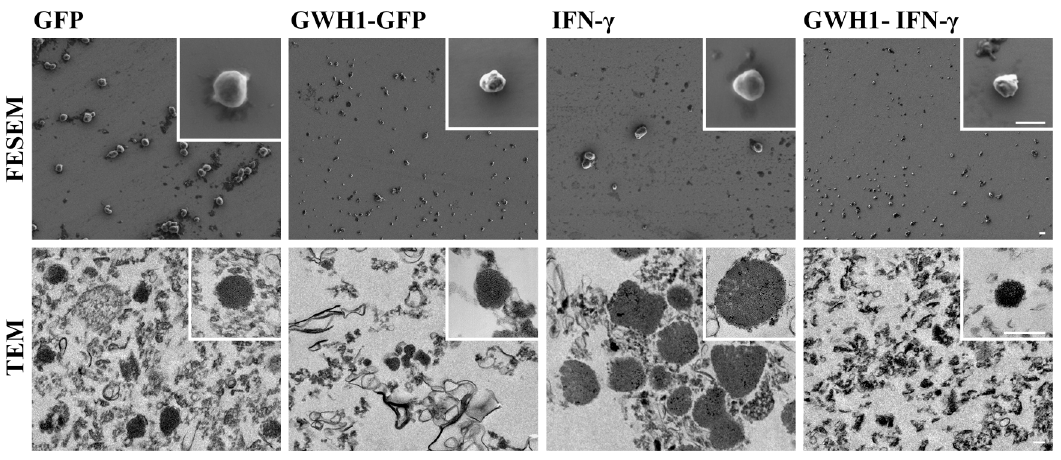
Figure 5. Ultrastructural characterization and analysis by electronic microscopy of purified inclusion bodies. Representative images of general fields and nanoparticle detail of entire IBs of GFP, GWH1-GFP, IFN- γ and GWH1-IFN- γ at two different magnifications, 11,000×/150,000× (FESEM) and 3000 × / 10,000 × (TEM). Magnifications are equivalent in each micrograph to allow comparative visualization. The scale bars represent 500 nm.